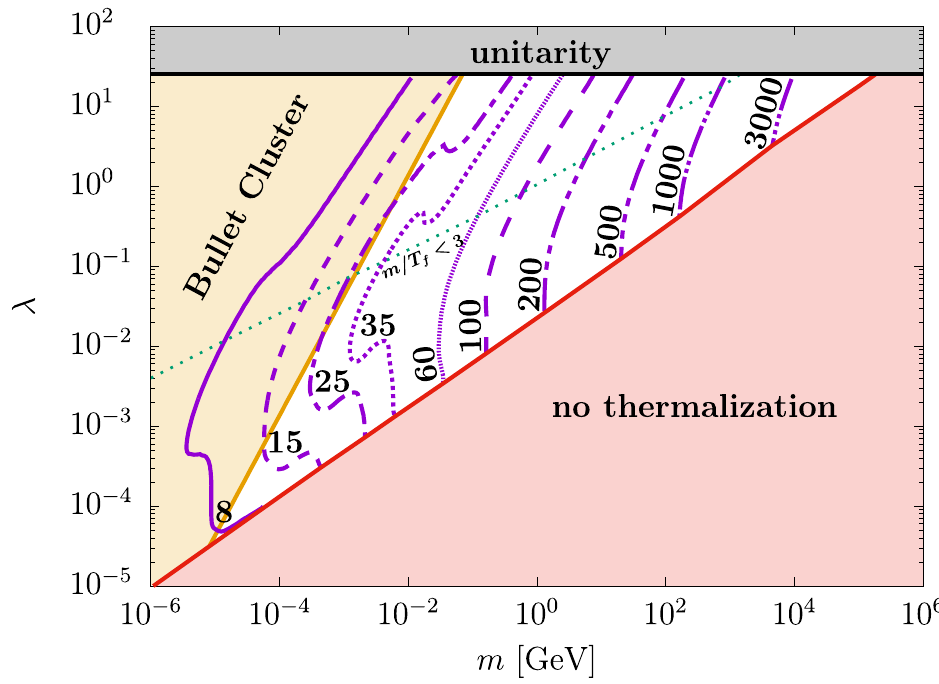
Figure 8 . Parameter region (white) consistent with the correct DM relic density, Bullet Cluster, thermalization, and perturbative unitarity constraints. Points lying on each curve reproduce the correct DM relic abundance for a specified ξ ( x f ) at freeze-out. In the red region, the relic density and freeze-out equations have no simultaneous